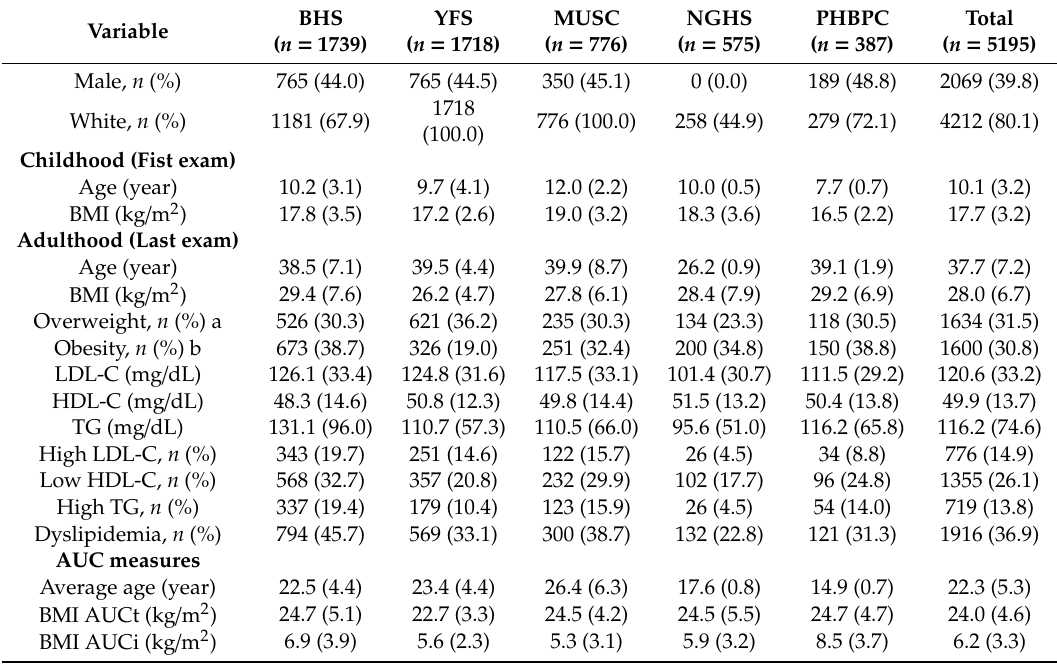
Table 1. Characteristics of study